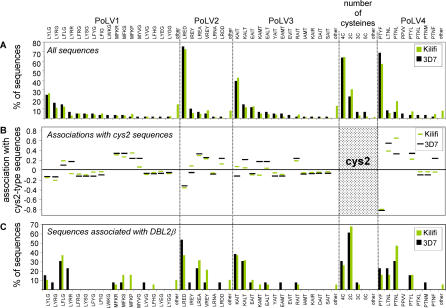
Conservation of Sequence Features between 3D7 and Kilifi Field Isolates(A) Distribution of sequence features within the 3D7 genome (black bars) and in Kilifi sequences (green bars). Sequence features not shared between Kenyan isolates and 3D7 are marked “other”.(B) Relationships between sequence features in sequences from Kilifi and 3D7: distribution of sequence features among cys2 sequences relative to those with non-cys2 sequences. The Cramer's V statistic (y-axis) indicates whether each of the listed sequence features was positively (V > 0) or negatively (V < 0) associated with cys2 sequences. Sequences from Kilifi are indicated with green bars; those from 3D7 are indicated by black bars.(C) The distribution of DBLα sequence features within var genes containing a DBL2β domain. PCR was performed on genomic DNA from two field isolates, 4161 and 4111 (see Figure 1A for amplification details). The percentage of distinct sequences containing each of the features listed is shown for Kilifi sequences (green bars) and is compared to the distribution of similar sequences from the 3D7 genome sequence (black bars).